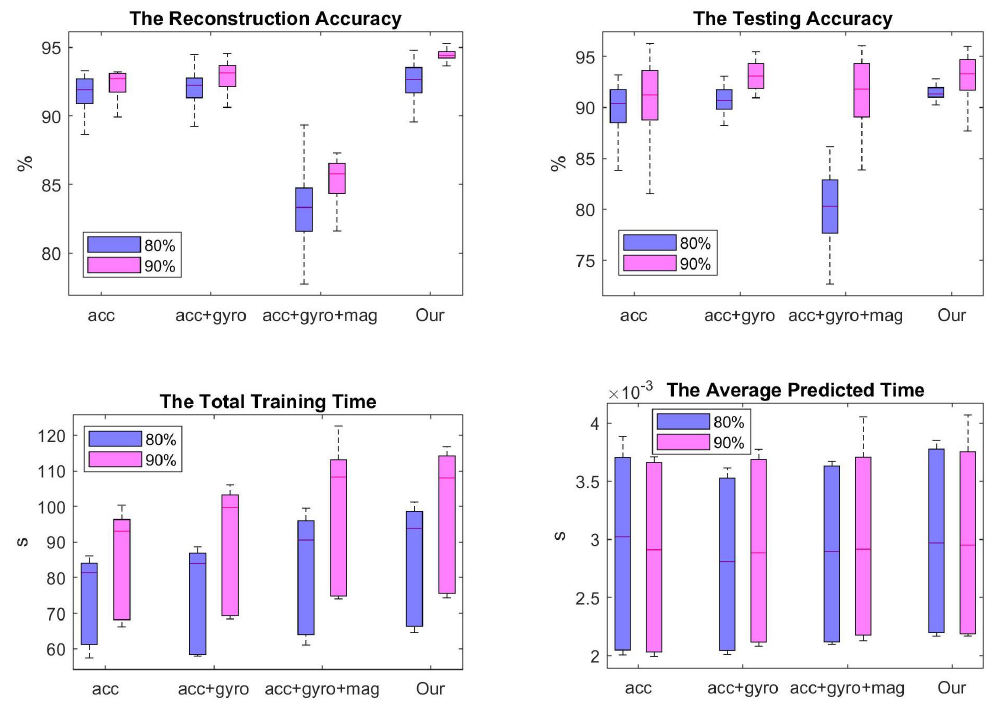
Figure 5. The comparison results among four types inputs: ’acc’ (˜ s ∗ = s α ), ’acc+gyro’ (˜ s ∗ = { s α , s β } ), } ). The reconstruction and testing ’acc+gyro+mag’ (˜ s ∗ = { s α , s β , s γ } ), and ’Our’ (˜ s ∗ = { s α 1 , s α 2 , s β 1 , s δ Y , Z accuracy are computed on the whole training and testing dataset, respectively. The total training time means the cost time for building the proposed DCNN classier. The average predicted time is to display the computational time to output an activity among these four kinds of